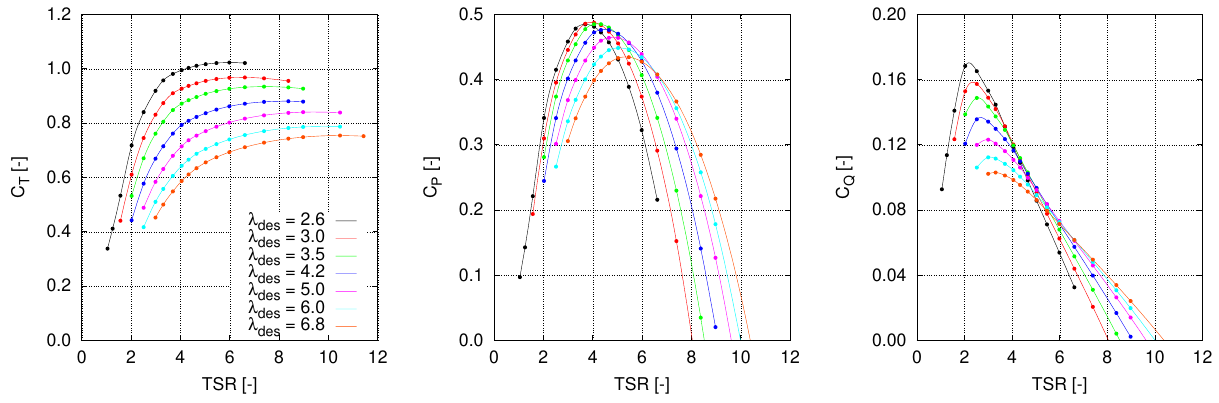
Fig. 23. Full-scale turbine: thrust, power and torque coefficient curves for λ des values from 2.6 to 6.8.